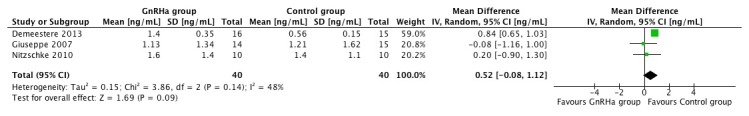
Forest plots showing AMH levels of eligible studies comparing GnRH agonists plus chemotherapy with chemotherapy alone.